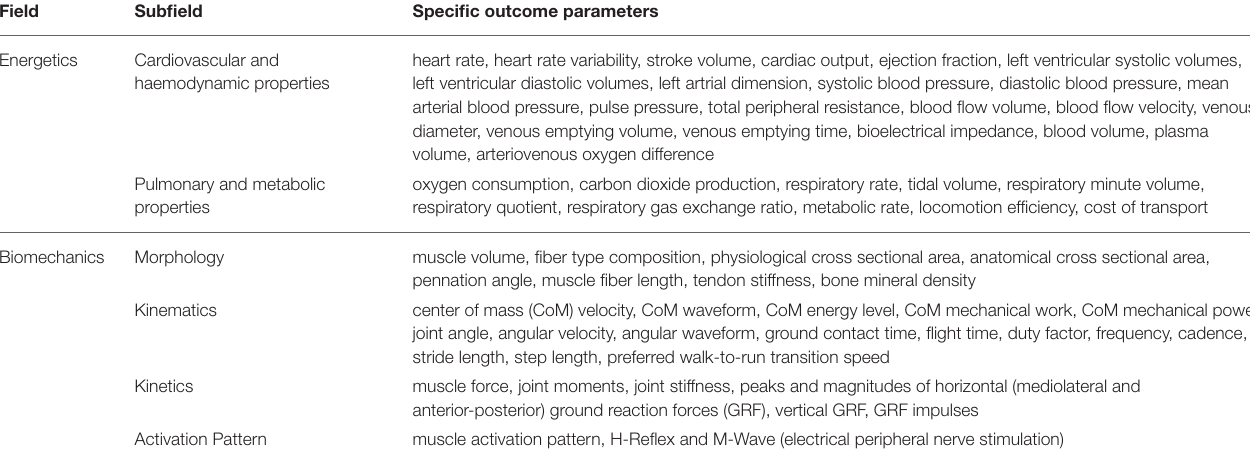
TABLE 2 | Outcome parameters for studies to be included.